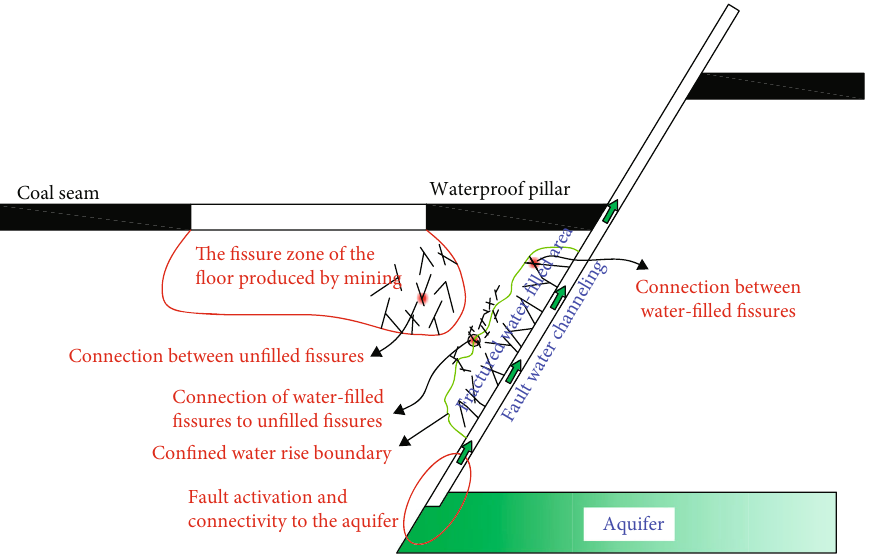
Figure 5: Crack propagation in rock mass with fault.